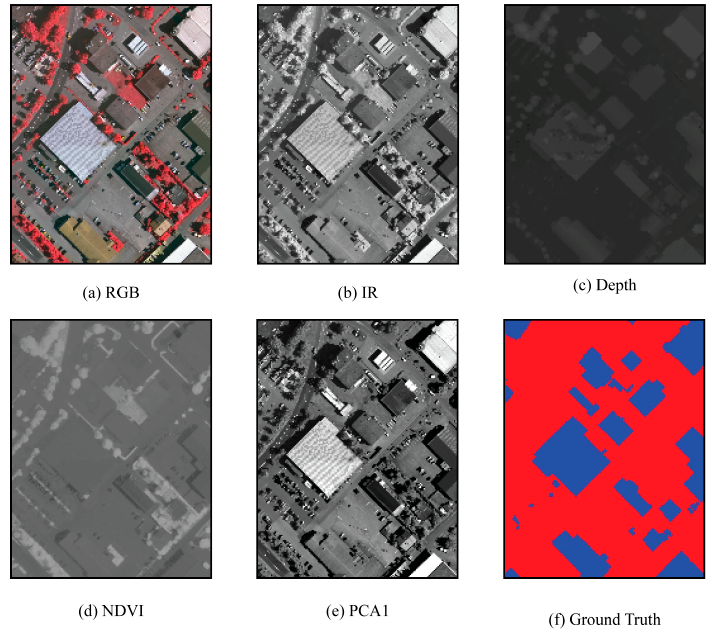
Figure 3. Samples of the urban remote sensing imageries used in the experiments.